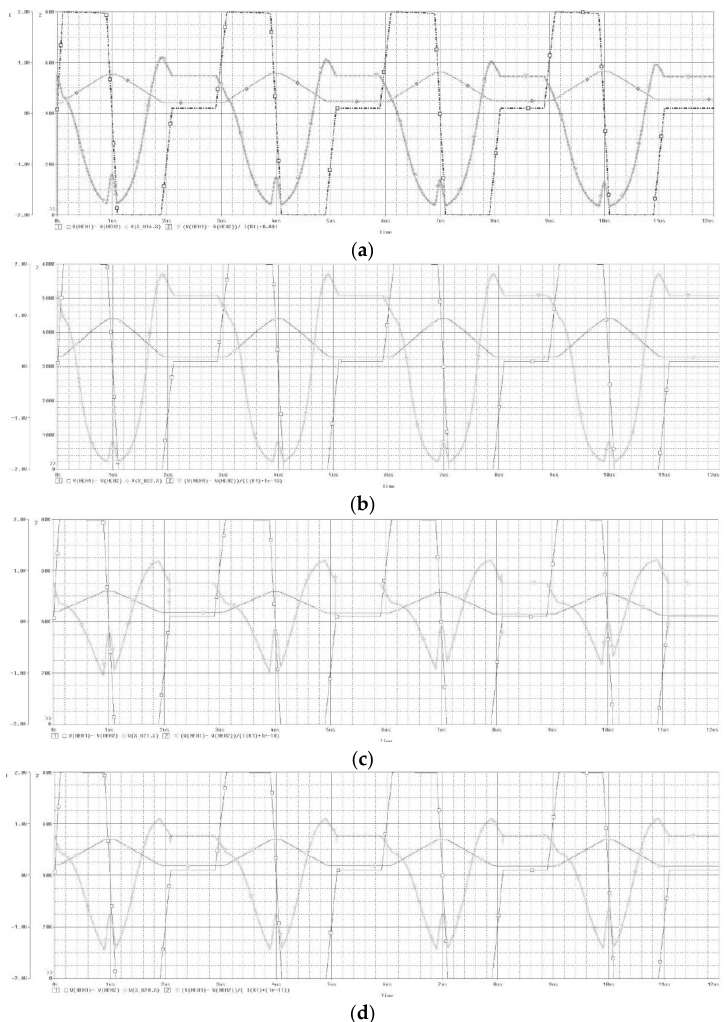
Figure 5. Time diagrams of the memristor voltage, state variable, and memristance for: ( a ) Biolek modified window function; ( b ) Joglekar modified window function; ( c ) Biolek original window function; ( d ) Joglekar original window function.